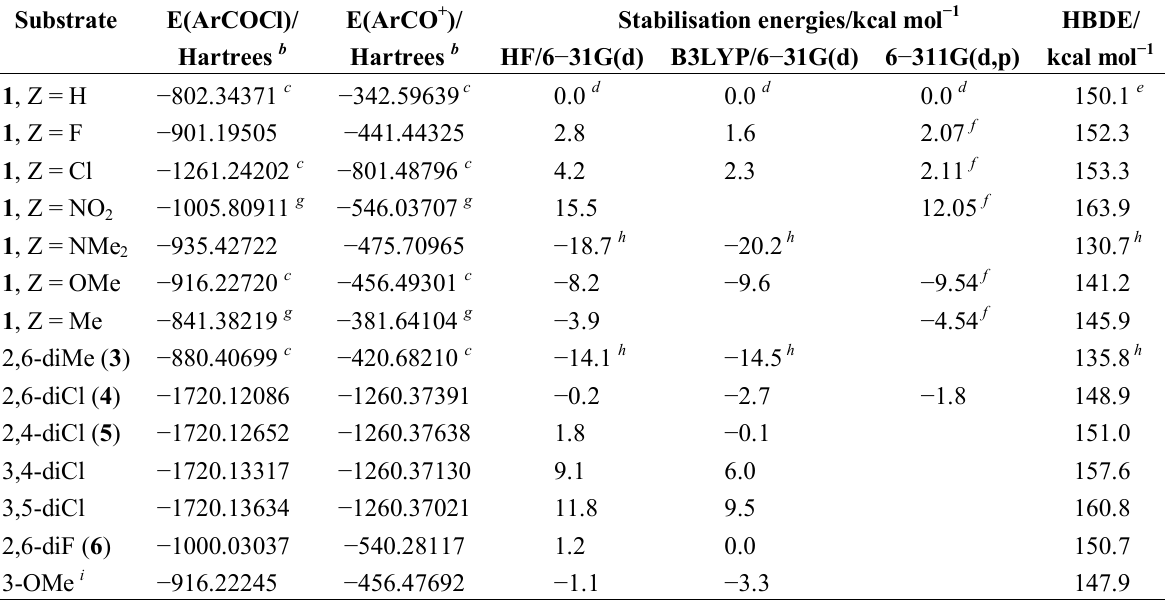
Table 4. Calculated energies, stabilisation energies (SE, Equation 2) and heterolytic bond dissociation energies (HBDE) for benzoyl chlorides a .